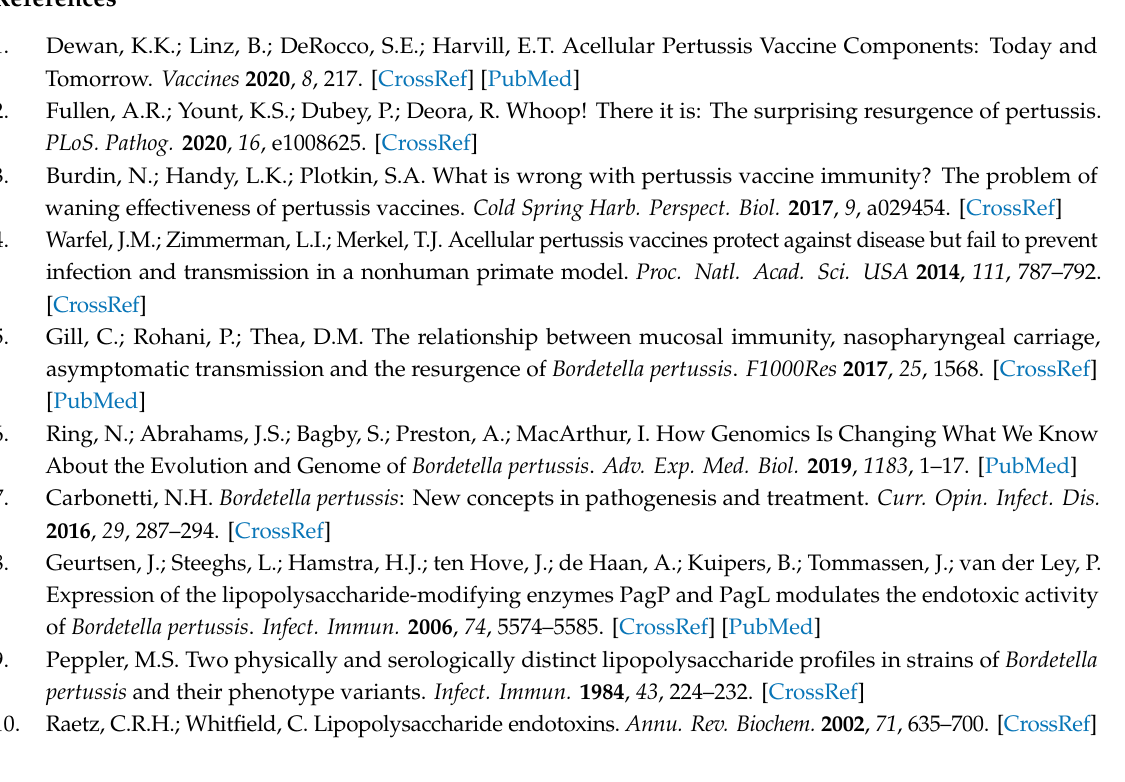
Figure S1. Expression of recombinant genes in E. coli BL21(DE3) and B. pertussis B213, Figure S2. Bioactivity of LPS of strain B1917 and derivatives, Figure S3. Comparison of the bioactivity of LPS of B. pertussis and E. coli LPS, Figure S4. Binding of agonist and antagonist lipid A variants by TLR4 / MD-2 complex, Table S1. Primers used in this